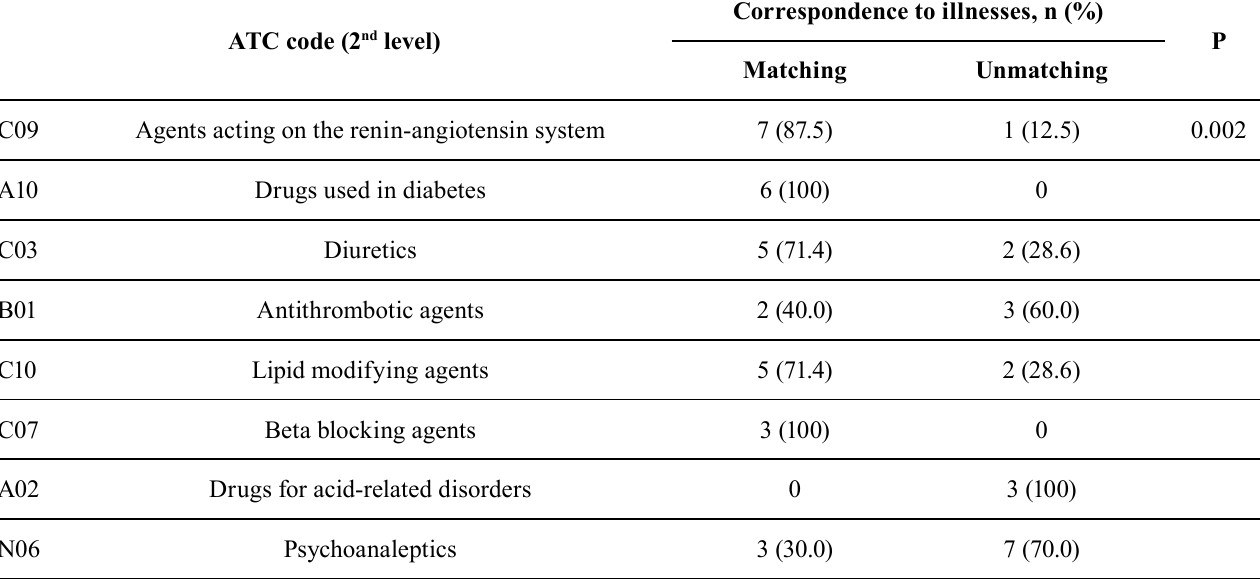
TABLE V – C orrespondence between indications and self-reported present illnesses across the eight most frequent 2 nd level ATC categories of medications whose indications were inappropriately recalled (N =